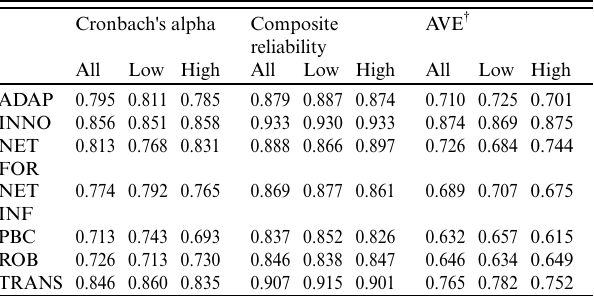
Table 3. Internal consistency reliability and convergent validity of the reduced model Cronbach's alpha Composite